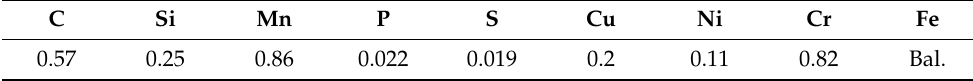
Table 1. Chemical composition of SUP9A (mass%).